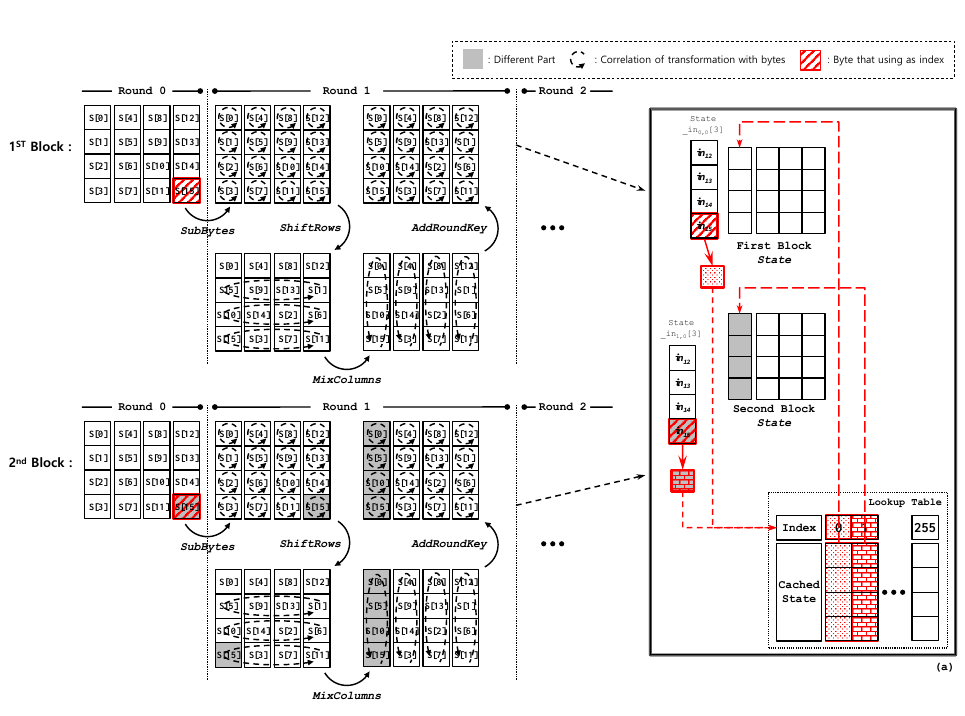
Figure 5: FACE rd 1+ : The process of AES round 1 and FACE rd 1+ . (a) shows how to refer the pre-computation